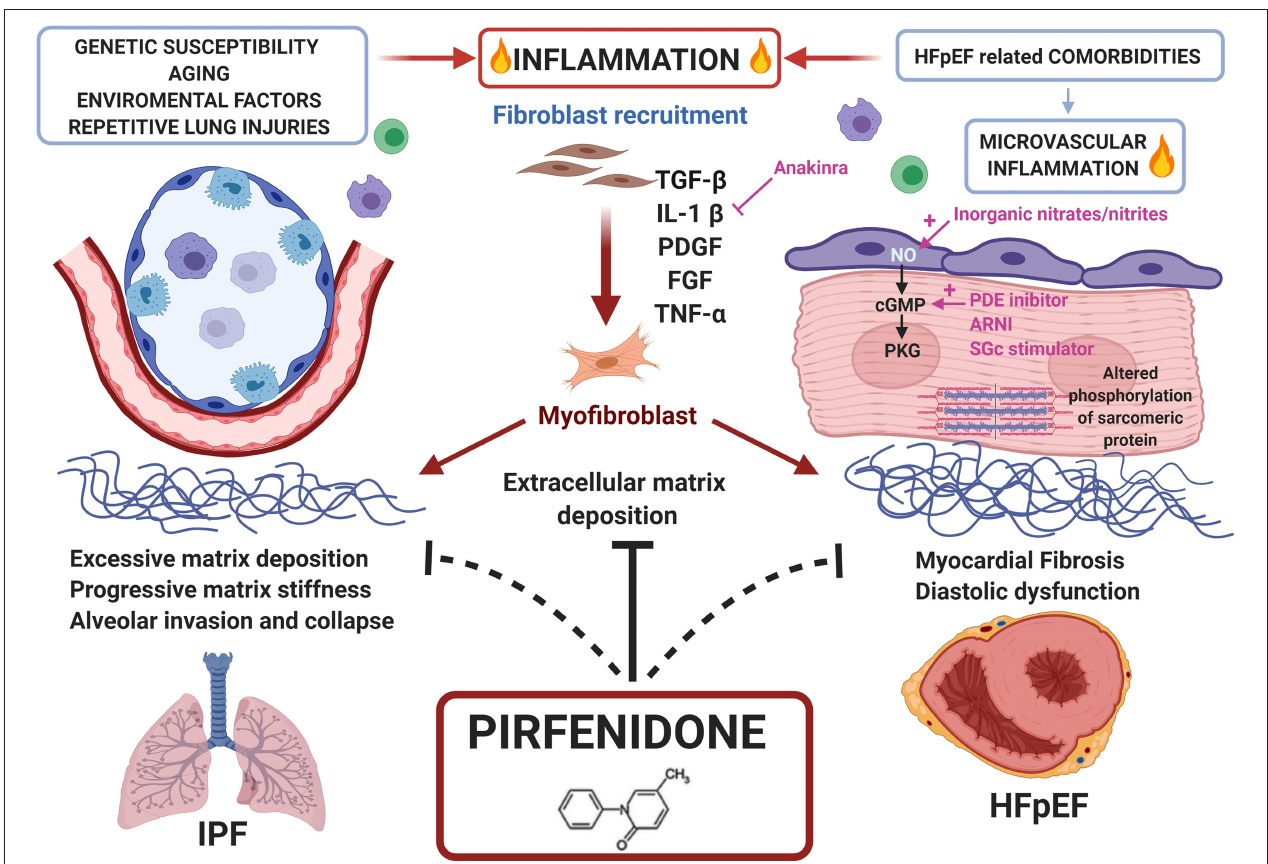
FIGURE 2 | Common pathways between HFpEF and IPF and potential role of Pirfenidone as treatment for both diseases. Repetitive lung injuries over a genetically susceptible alveolar epithelium, activates inflammatory pathways and the overproduction of pro-fibrotic mediators like transforming growth factor (TGF)- β , enhancing fibroblast recruitment, and conversion to myofibroblast. Similarly, HFpEF comorbidities trigger microvascular inflammation converging to myocardial fibrosis. Pirfenidone, an antifibrotic and anti-inflammatory drug approved for clinical use in IPF, may be proposed for HFpEF